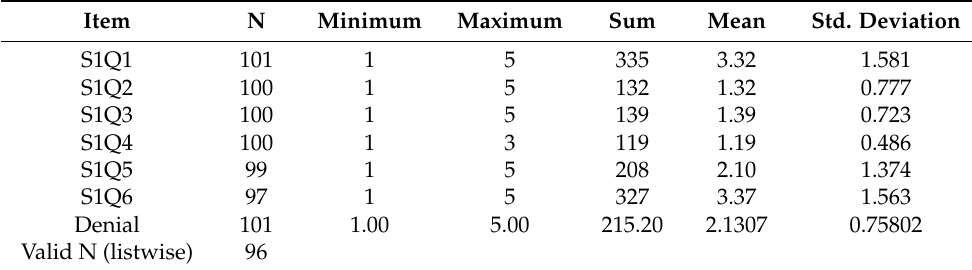
Table 2. Descriptive statistics of perception of the denial